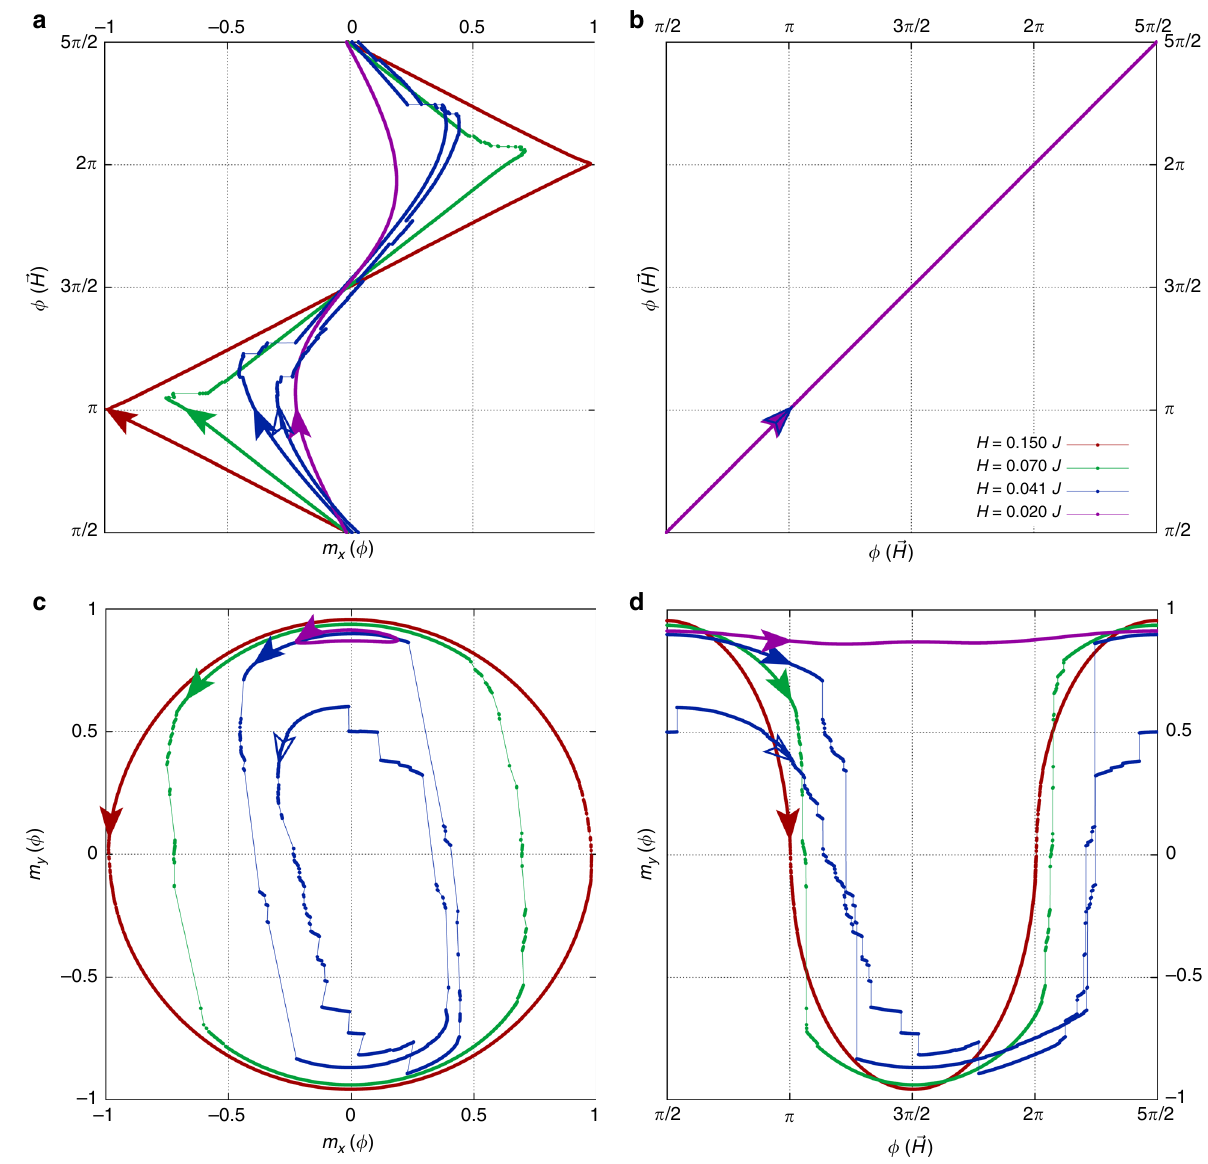
Fig. 1 Steady-state response to rotating applied fi eld at T = 0. A system of size N = 160 × 160 with R x = 0.5 J is started from an initial applied fi eld in the y -direction. The initial spin con fi guration is aligned with the applied fi eld, then relaxed according to Eq. (3) as described in the text, after which the applied fi eld is rotated counterclockwise as denoted in b . a , c , d show the response once steady state is reached under the driving fi eld. a shows the response of the magnetization in the x direction, while d shows the response of the magnetization in the y direction. c is a parametric plot of m y vs. m x . In all panels, the arrows denote the state of the system when the driving fi eld is at an angle ϕ = π , i.e., aligned along the x direction. For driving fi eld strength H = 0.041 J , the response of the system has double the period of the driving fi eld. The open arrow on this trace denotes the state of the system at driving fi eld angle ϕ = π during every other cycle of the driving fi